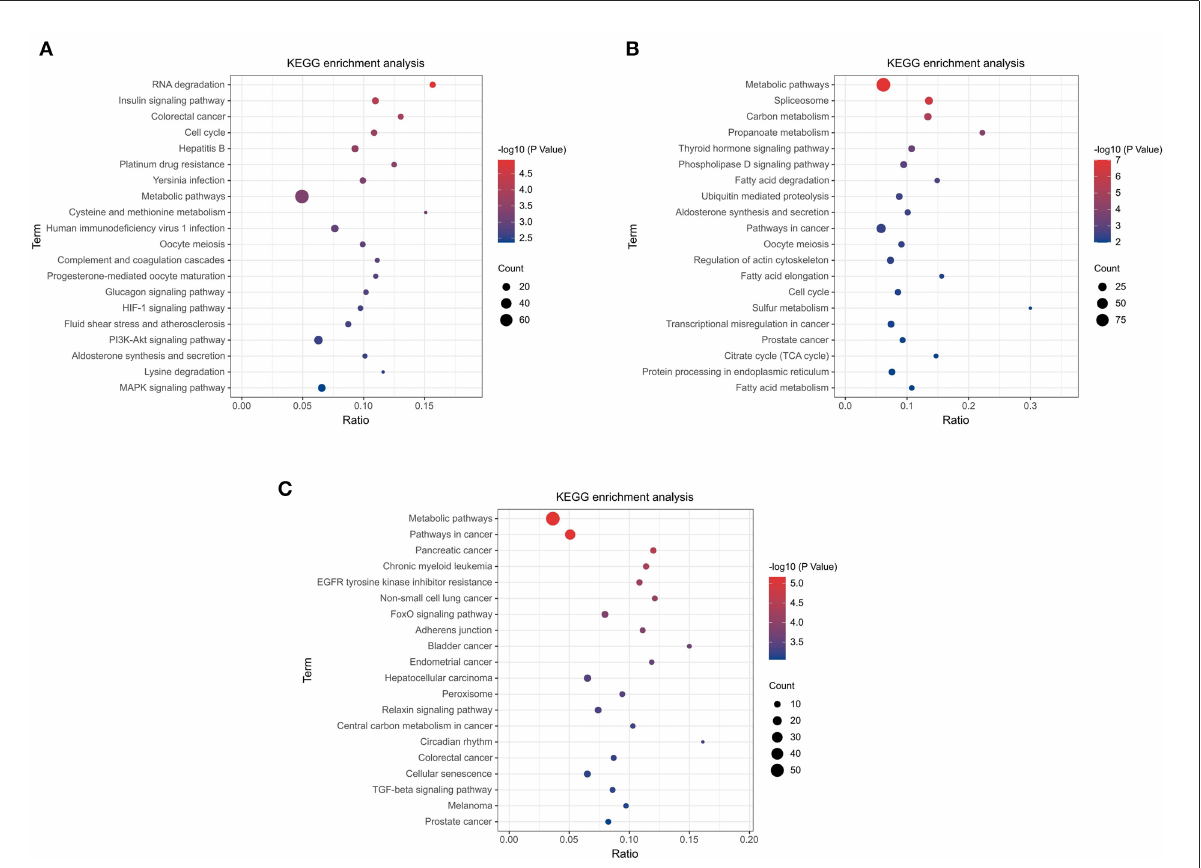
FIGURE5 KEGG enrichment analysis of DElncRNAs and DEmRNAs. (A) QD-QP. (B) QE-QP. (C) QM-QP.